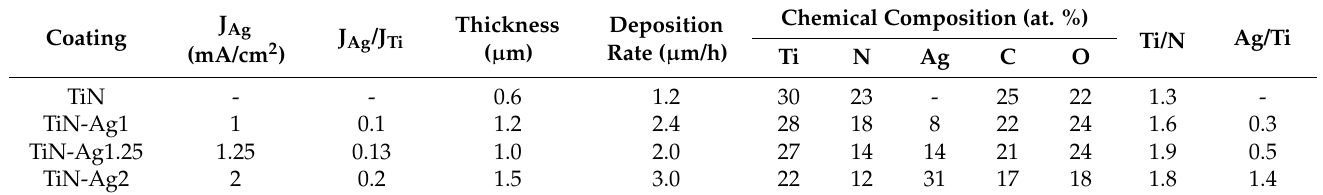
Table 1. The chemical composition, as well as some experimental details. The power density applied to the Ag target was used to identify the Ag-TiNx